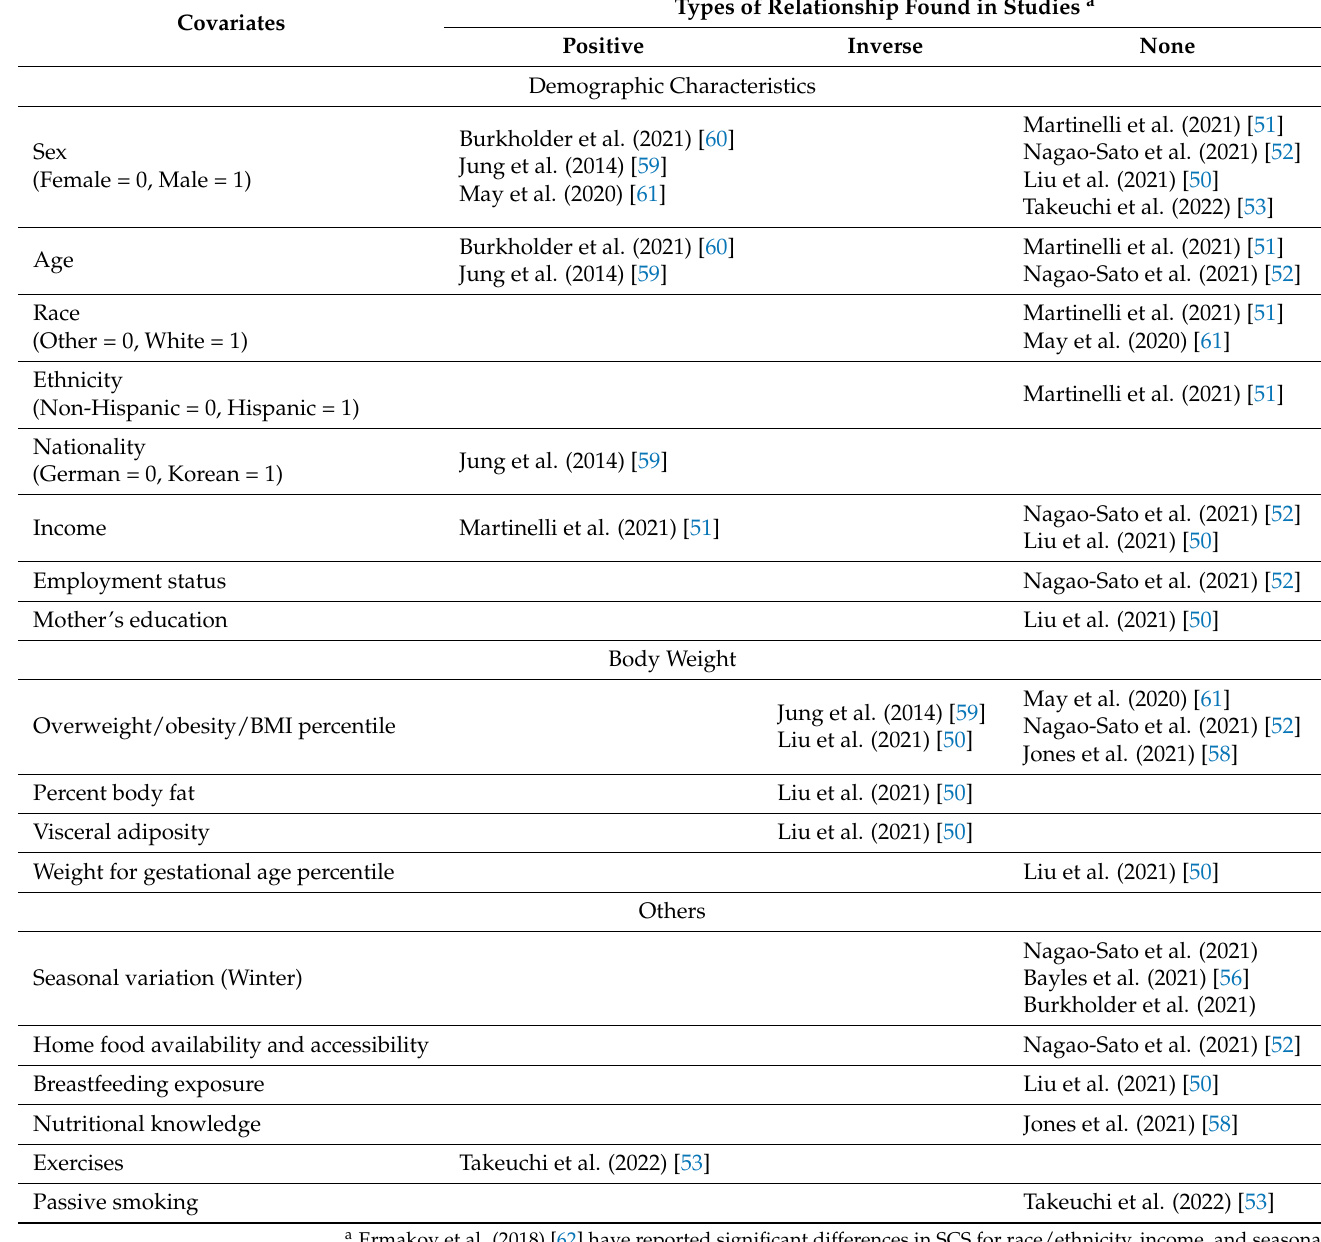
Table 4. Potential non-dietary correlates and their relationship with children’s RS-based skin carotenoid